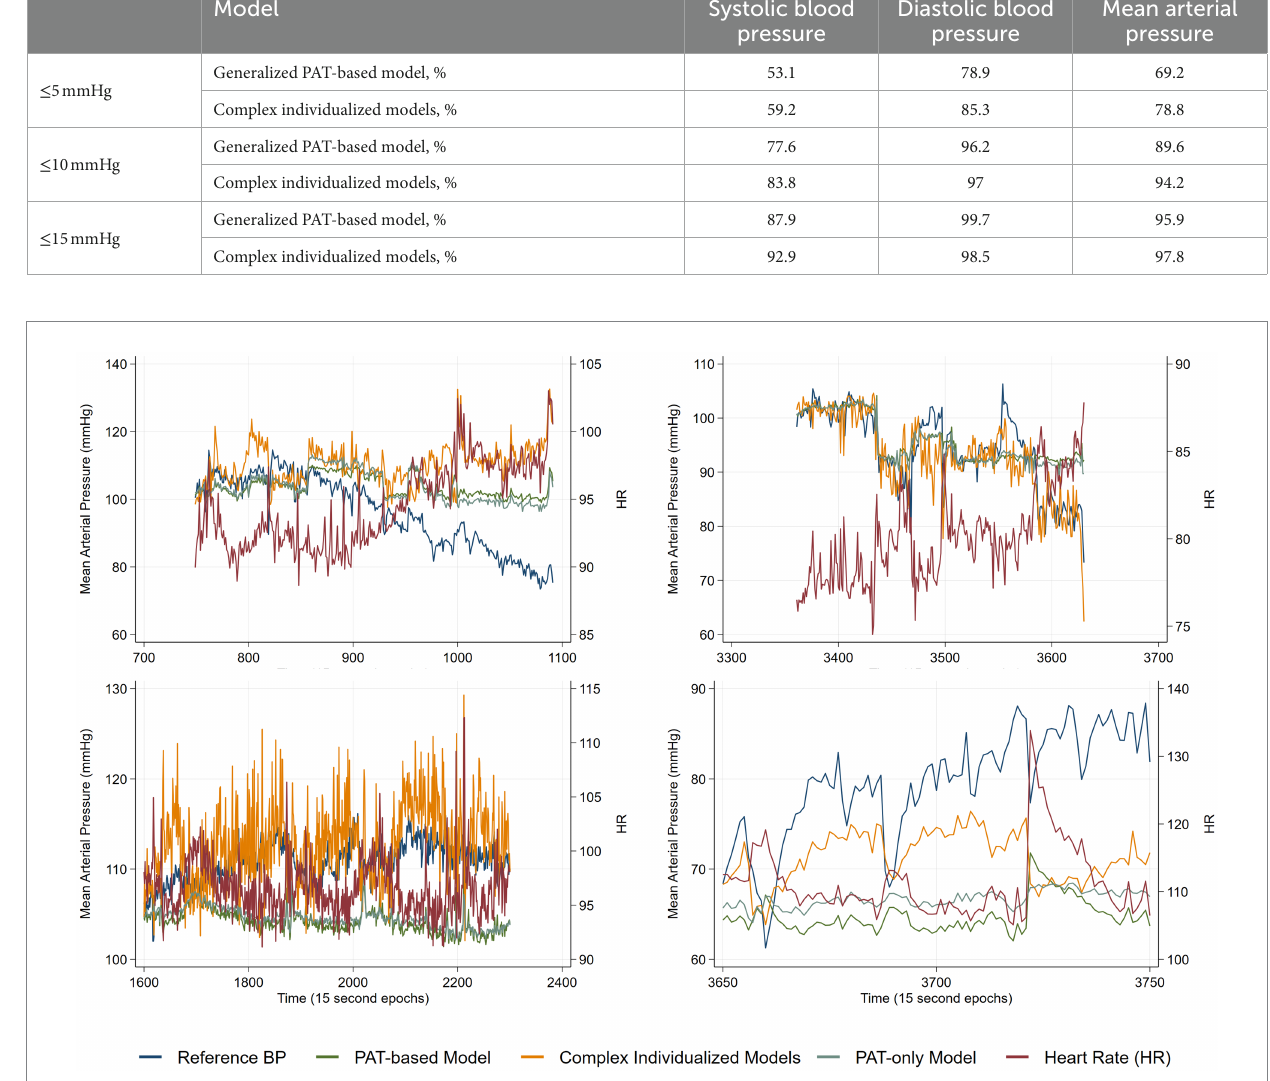
FIGURE 4 Time series plots from four different patients of reference mean arterial pressure (MAP), heart rate (HR) and predicted MAP from the two models in addition to predicted MAP from a PAT-only model.